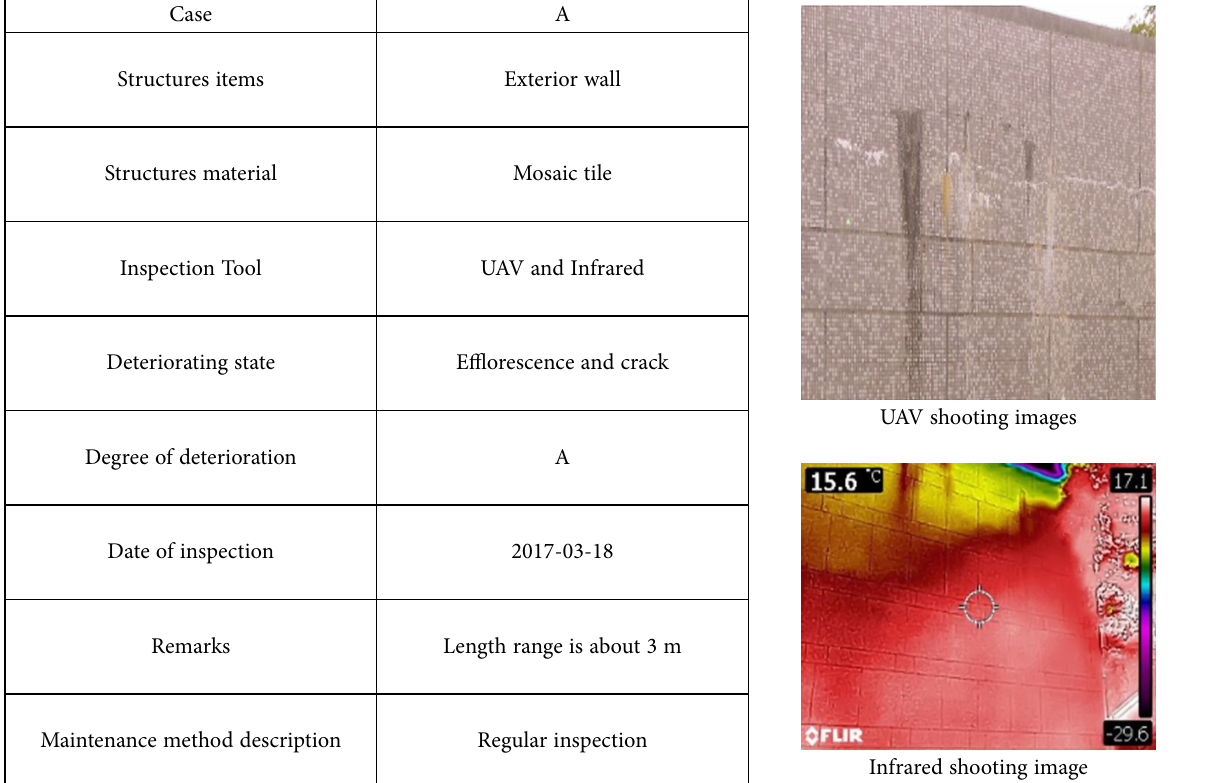
Figure 12. The web interface output of case A